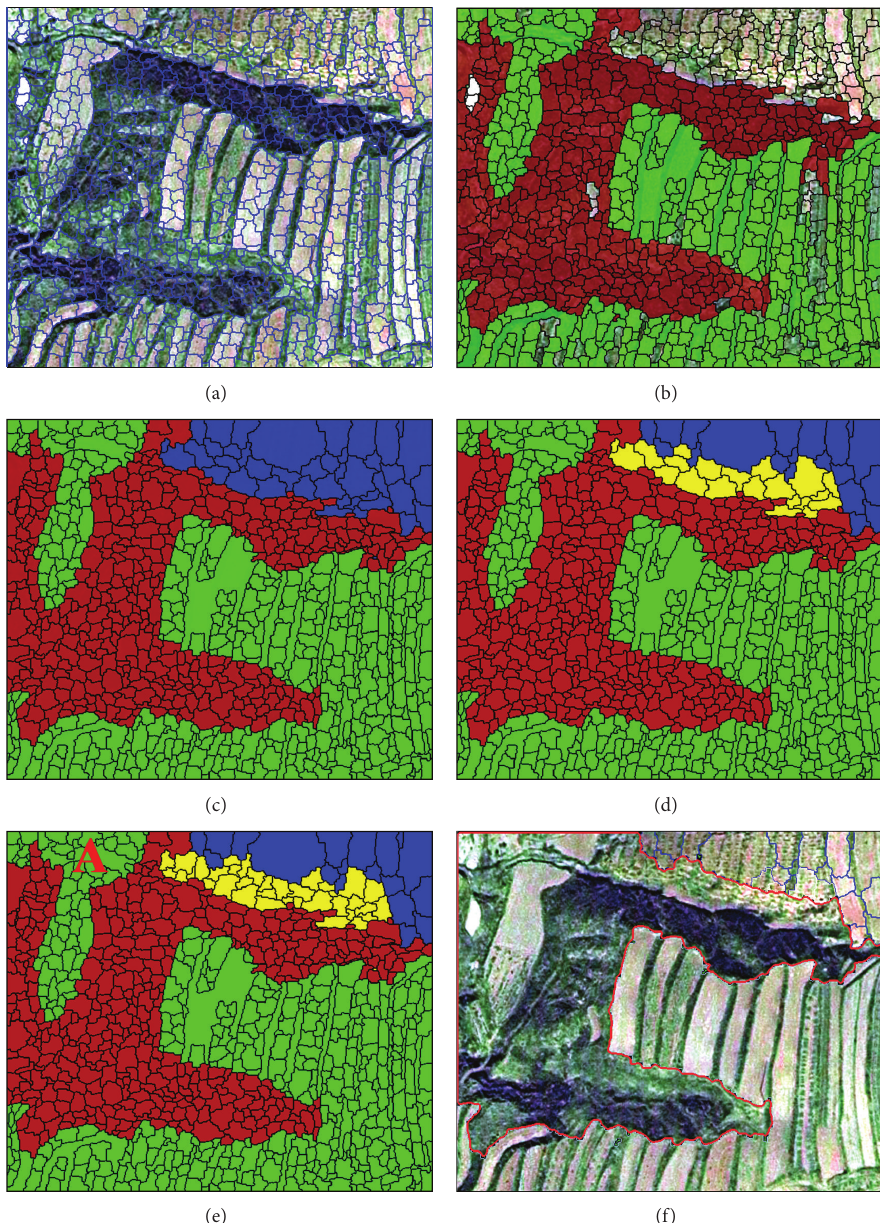
Figure 6: Steps of extracting gully erosion features using the OOA